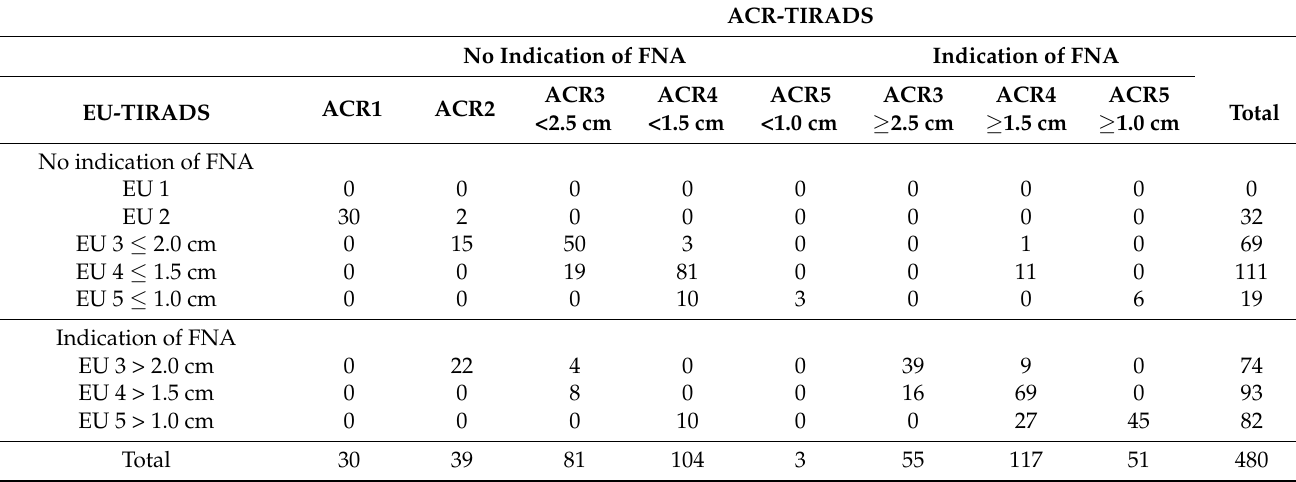
Table 1. Comparison between the ACR and EU-TIRADS systems in the indication to perform FNA.